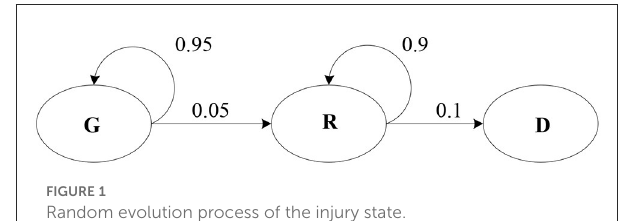
FIGURE1 Random evolution process of the injury